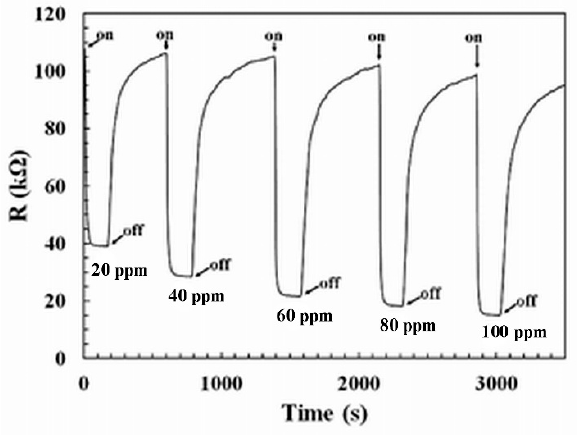
10 of 13 Figure 8. Sensitivity of sensor-400 (a) and sensor-500 (b) versus the H 2 S concentration at 350 °C. The dots are experimental values. The lines are the fitting curves obtained with Equation (10). 5. Dynamic Response of the Sensors under H 2 S and Discussion The dynamic response under H 2 S pulses at concentration ranging from 20 to 100 ppm for the most sensitive sensor, i.e., sensor-400, is presented in Figure 9. In the presence of H 2 S, the sensor resistance decreased. This is a typical response for an n-type oxide under